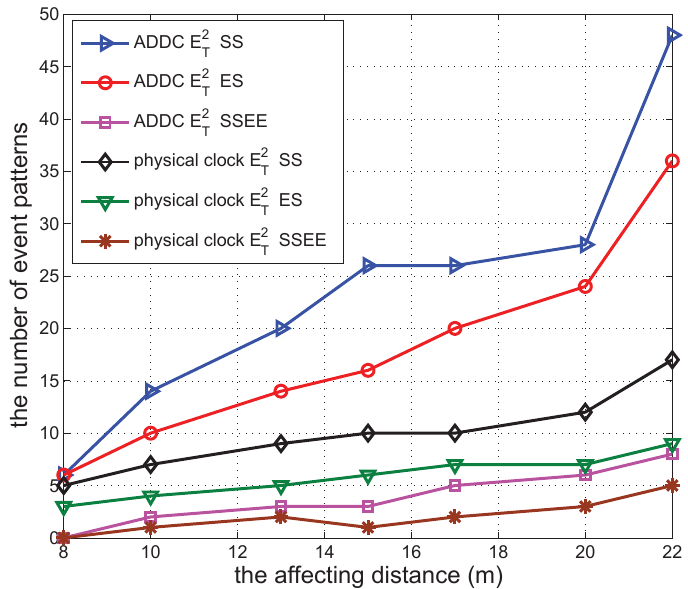
Figure 12. The number of event patterns vs. affecting distance.